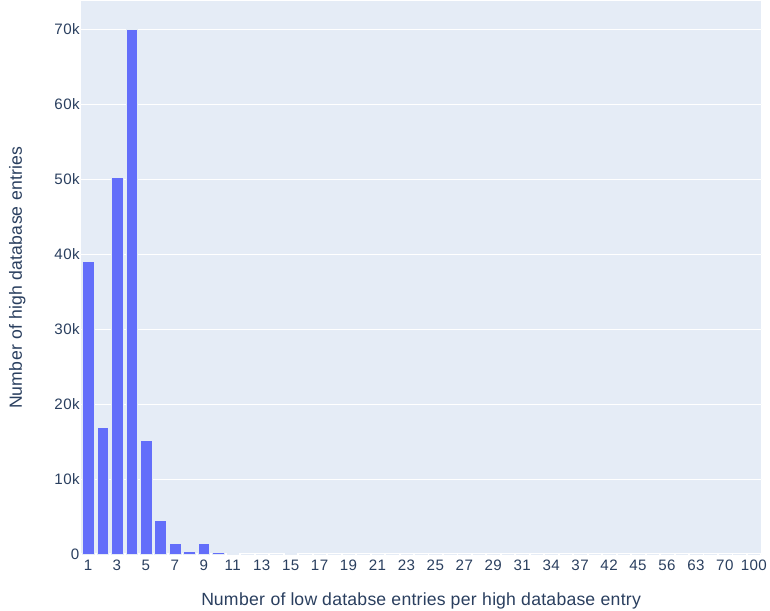
Figure 4. Number of high database entries containing data from a given number of the low database entries.